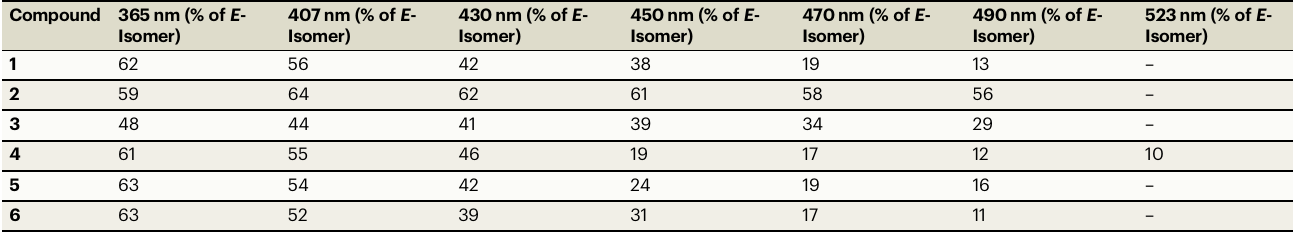
Table 1 | Photostationary state (PSS) composition of the compounds 1-6 Compound 365nm (% of E - Isomer)